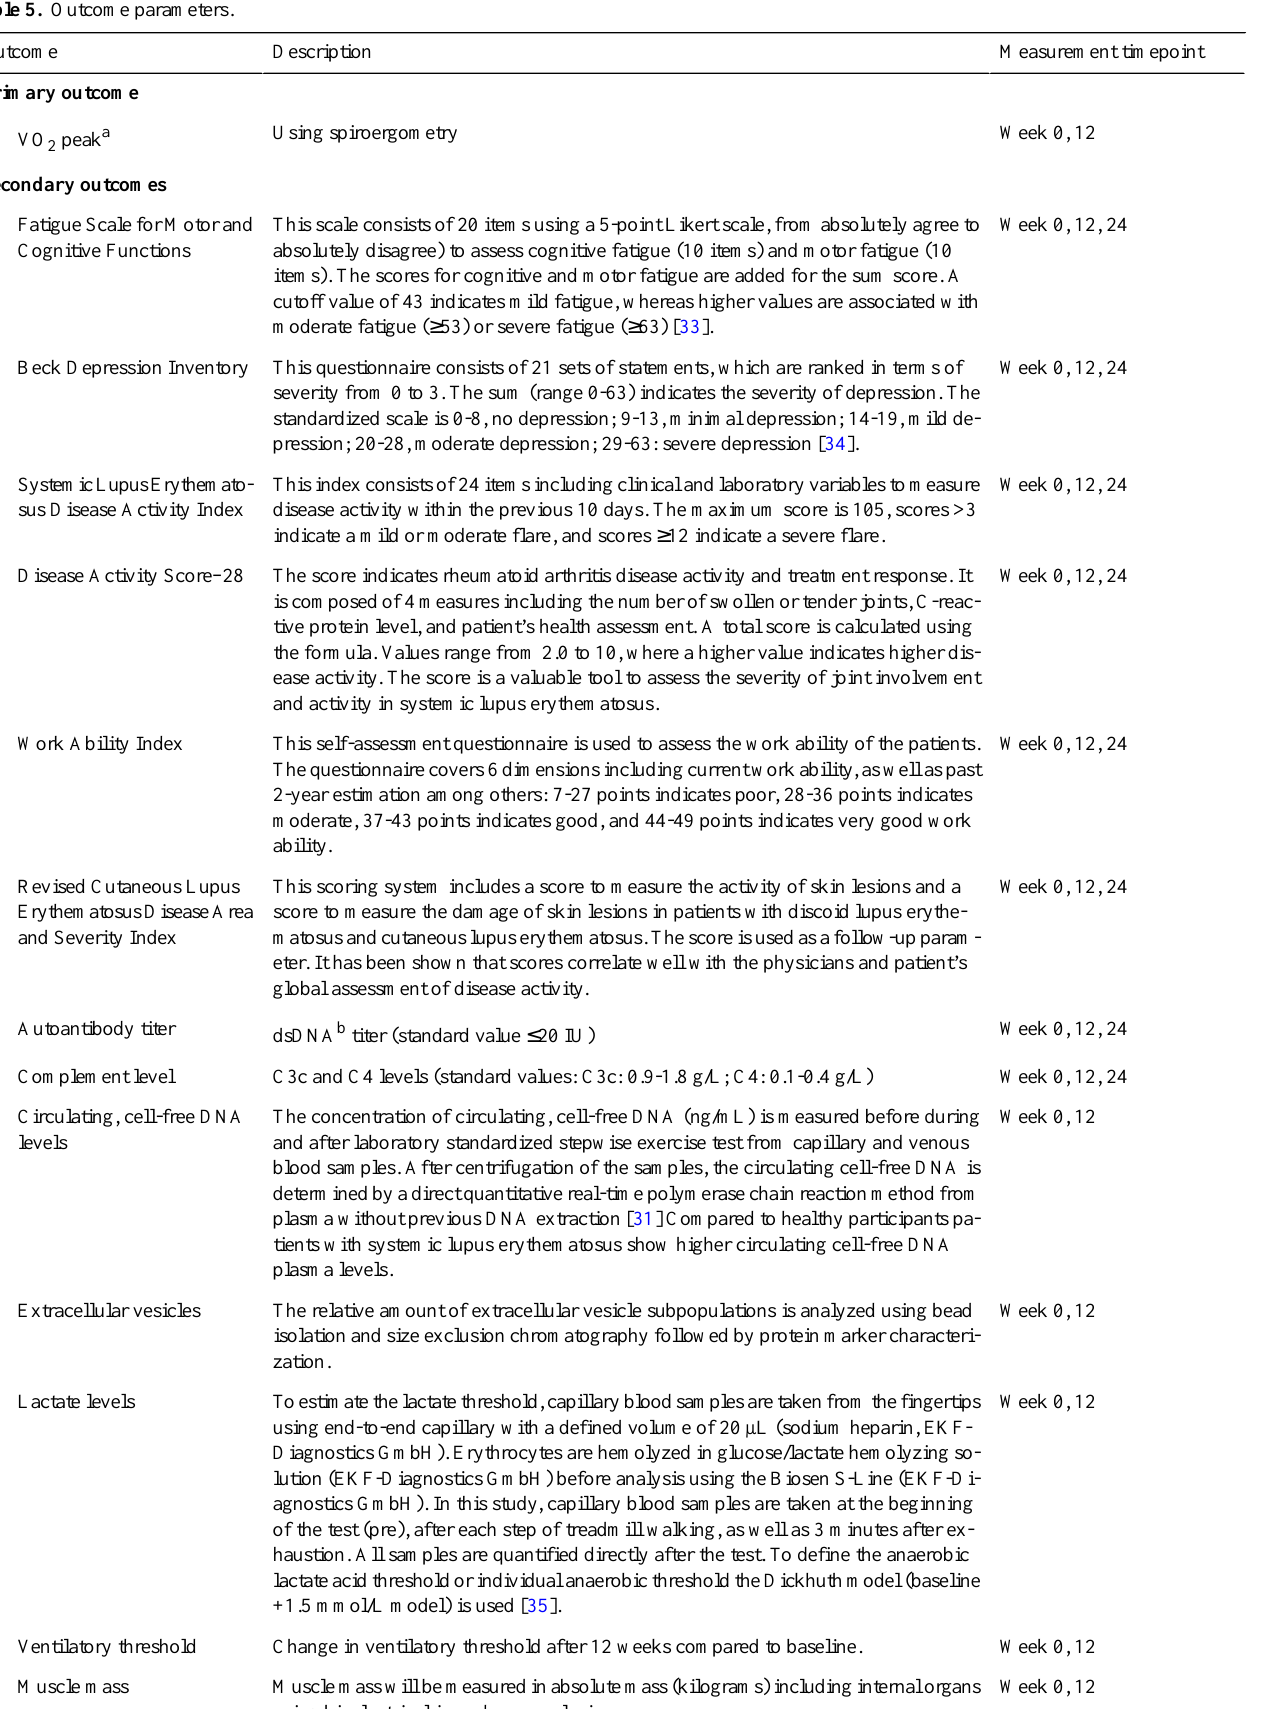
Table 5. Outcome